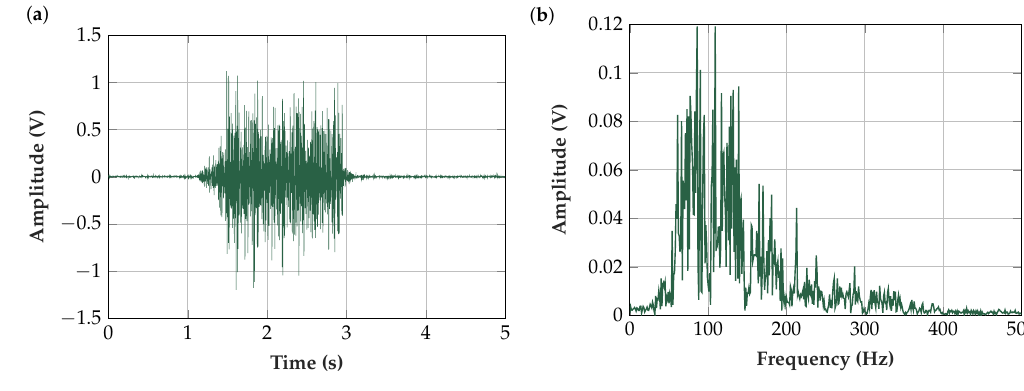
Figure 13. ( a ) EMG contraction measured with our insulated EMG measurement set-up using Sensor 5 (flex sensor with Platilon R (cid:13) foil) and an oscilloscope [66] at 10 kHz sampling frequency; and ( b ) amplitude spectrum of contraction EMG at 1.7–2.7 s (resolution ∆ f = 1 Hz). The damping characteristic of the highpass filters and the notch filter at 50 Hz and its harmonics can be seen.